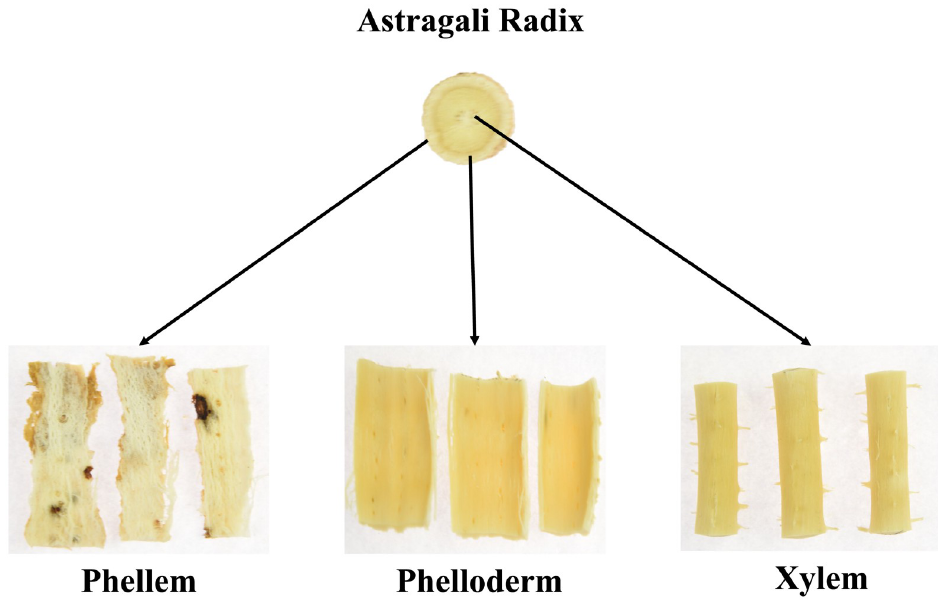
Fig 6. Anatomy of Astragali